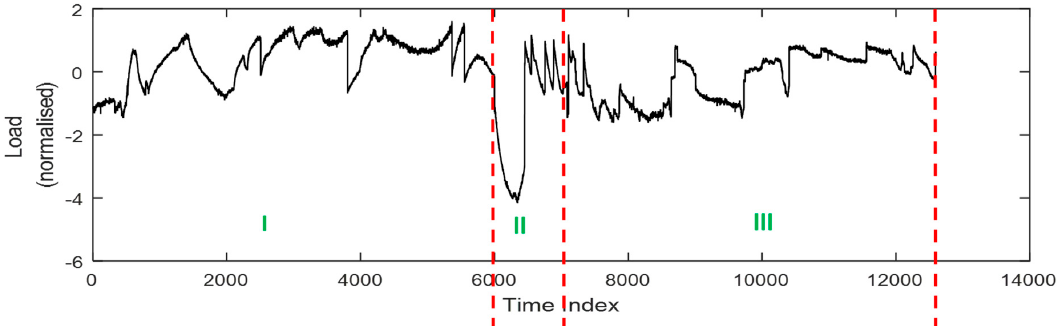
Figure 7. The normalized mill load with labelled states: (I) normal operating condition (NOC), (II) Feed disturbance, (III) Feed limited.